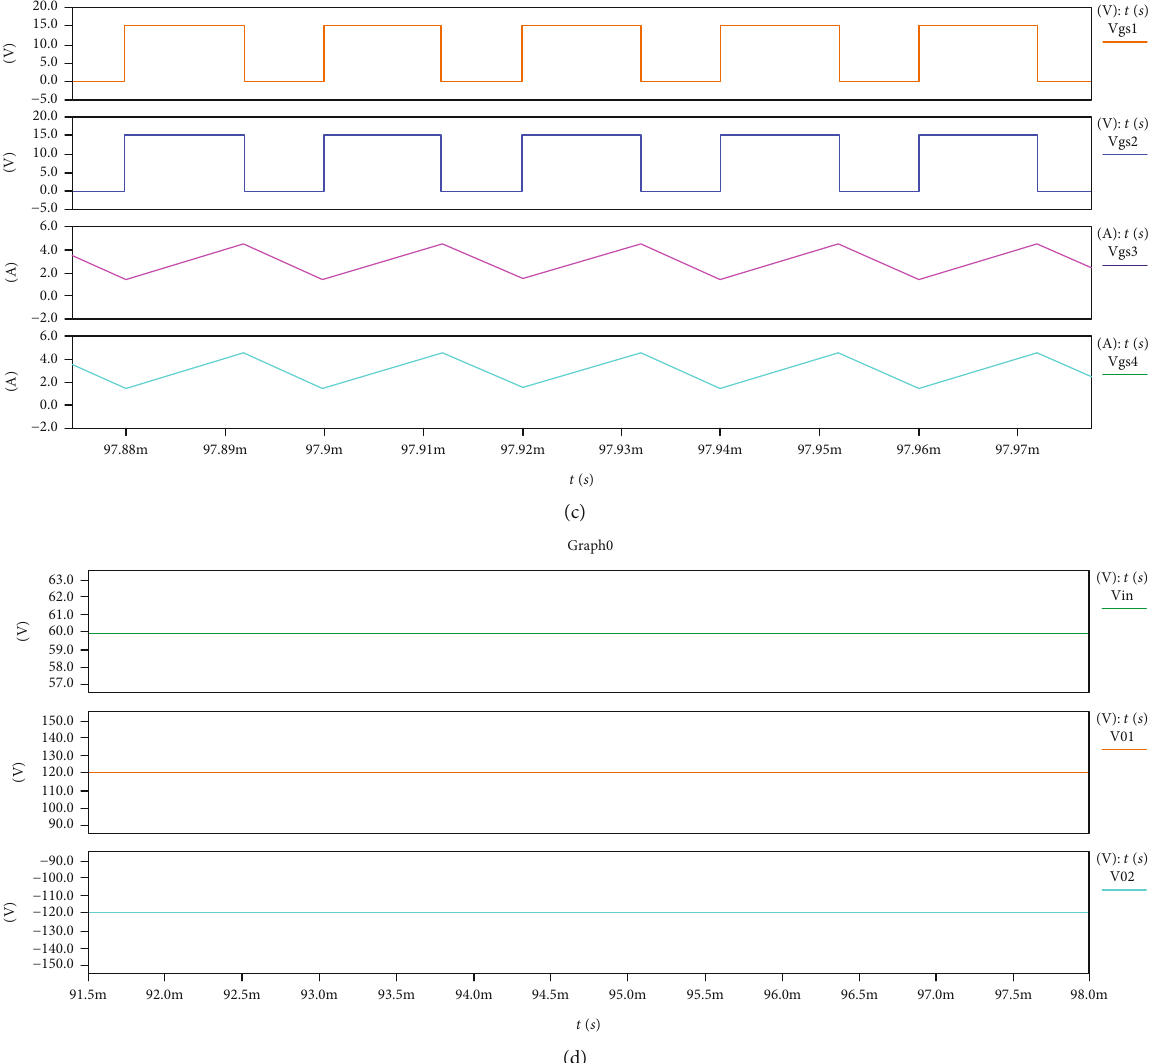
, V , V , V ; (b) V gs1 gs2 ds1 ds2